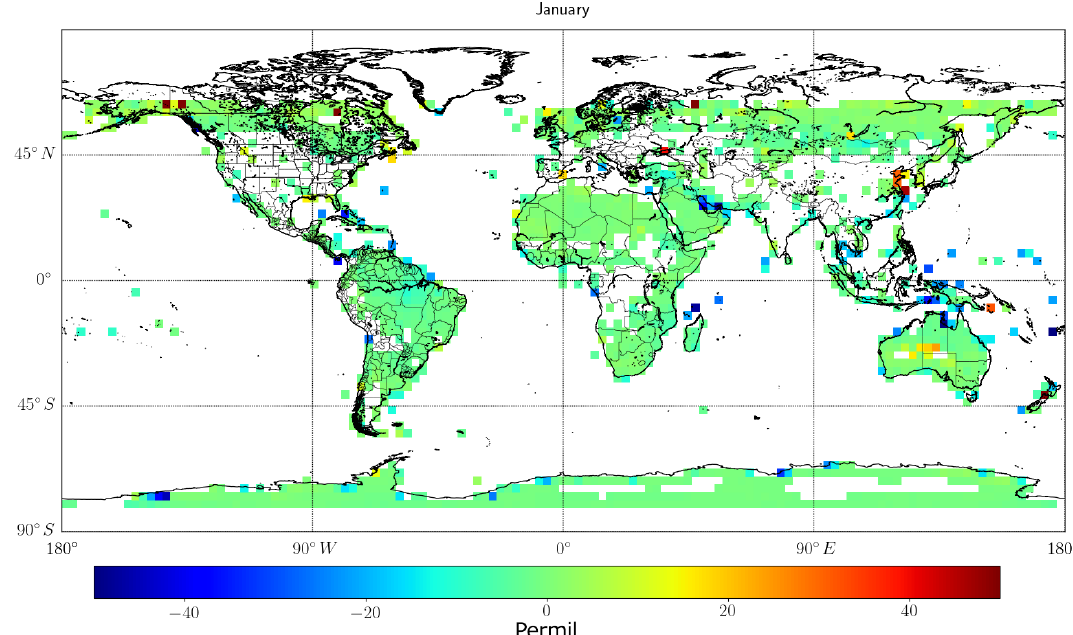
Figure 18. As Figs. 16 and 17 but focused on dual-band